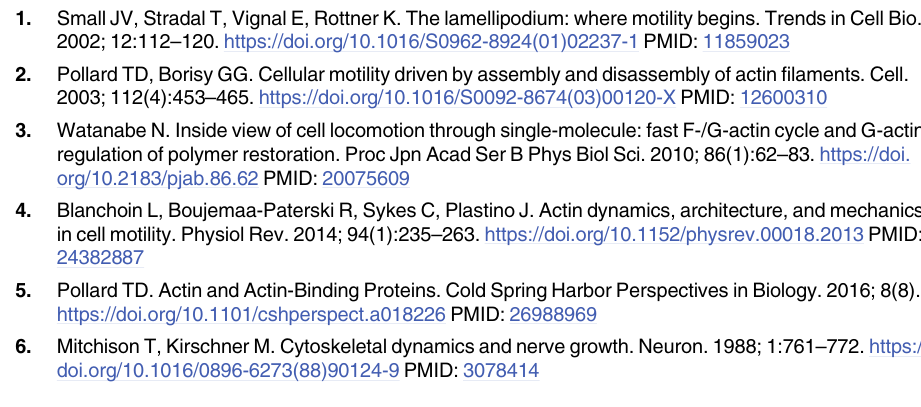
S4 Movie. Varying dynamic crosslinker concentration in simulation with mature focal adhesion and long-lived crosslinkers. Bottom row of Fig 6 where long-lived crosslinker life- time is 20 s and C = 1, 10, 30 μM , over 30 seconds. Blue line segments represent long- dynamic lived crosslinkers while green line segments represent dynamic crosslinkers. (MP4) S5 Movie. Simulations showing formation of microspike-like bundles. Microspikes forma- tion as in Fig 7. Blue line segments represent permanent crosslinkers while green line segments represent dynamic crosslinkers.